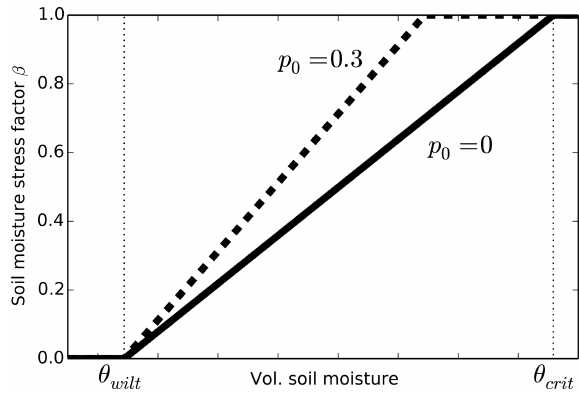
Figure 1. JULES soil moisture stress factor β with p 0 = 0 (solid line) and p 0 = 0 . 3 (dashed line). The soil moisture threshold at which the plant becomes completely unstressed ( β = 1) is θ wilt + (θ crit − θ wilt )( 1 − p 0 )